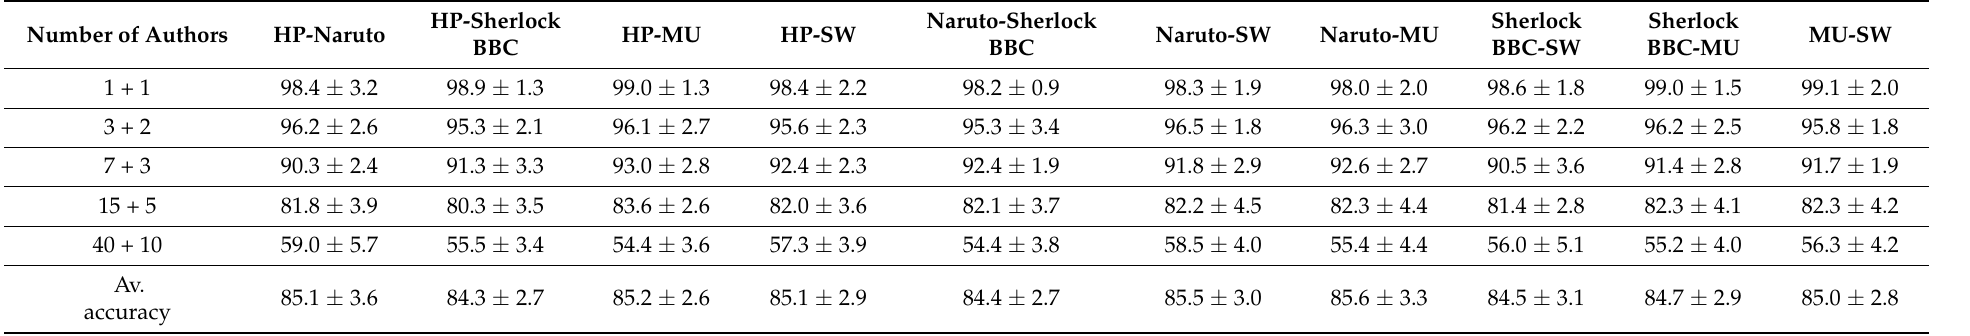
Table 10. One-Class SVM + fastText result for cross-topic case.